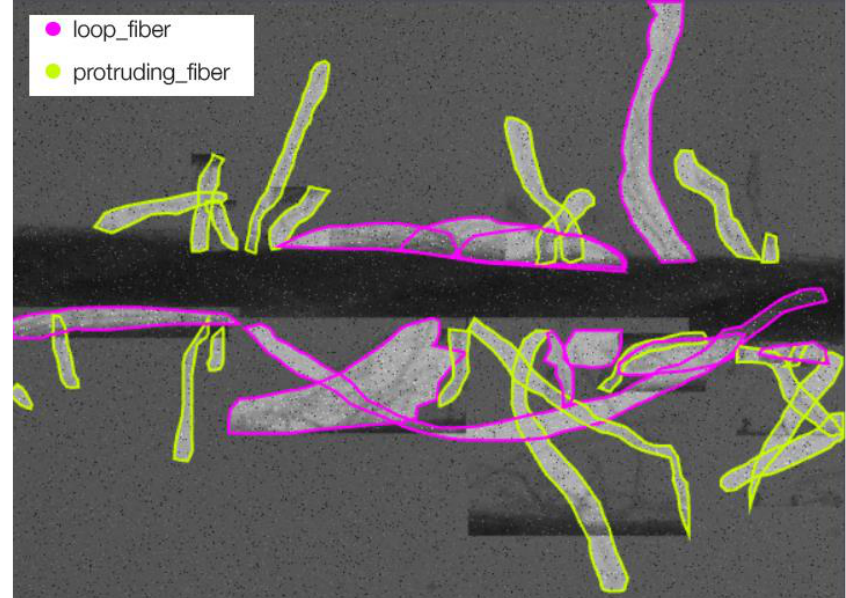
Figure 43. Data augmentation of the dataset used in the project.